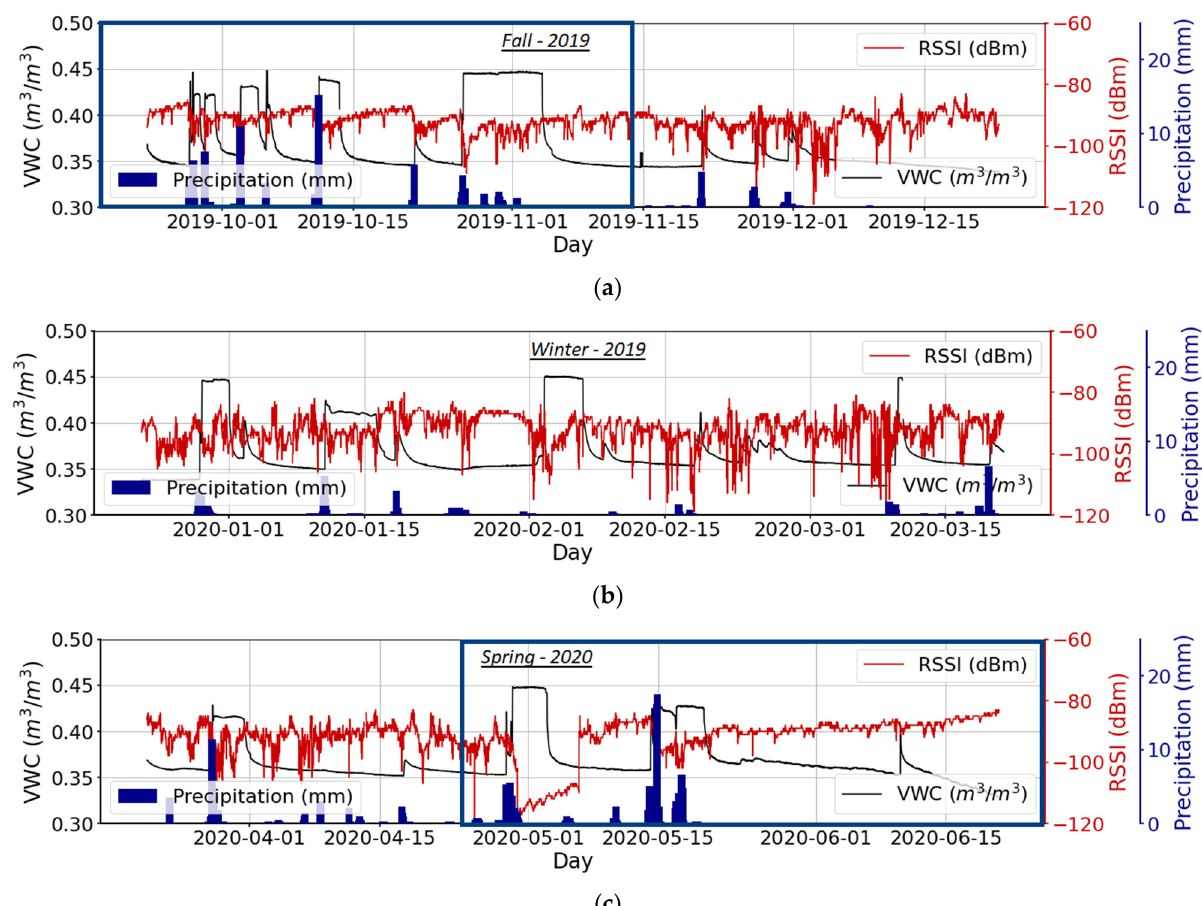
Figure 6. Measured RSSI (red line) and VWC (black line) by a sensor node buried 40 cm below the ground and located at 5 m to the base station during fall 2019 ( a ), winter 2019 ( b ), and spring 2020 ( c ) (from 6 September 2019 to 20 June 2020). Blue bars represent cumulative daily precipitation.